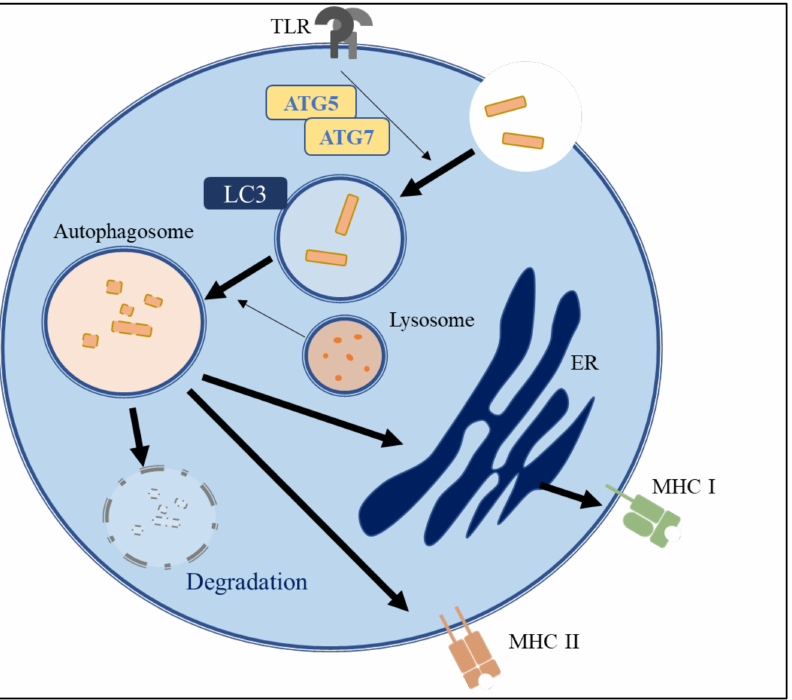
Figure 4. The role of autophagy in immune systems. Autophagy and autophagy-associated proteins are required for pathogen clearance and antigen-presenting signaling in the immune system. LC3 takes part in the capacity to clear apoptotic cells and pathogens in innate immune responses. In the adaptive immune system, ATG5 involves in MHC class I and MHC class II antigen presentation in APCs leading to the T cell responses. Autophagy-associated proteins plays an important role in the innate and adaptive immune